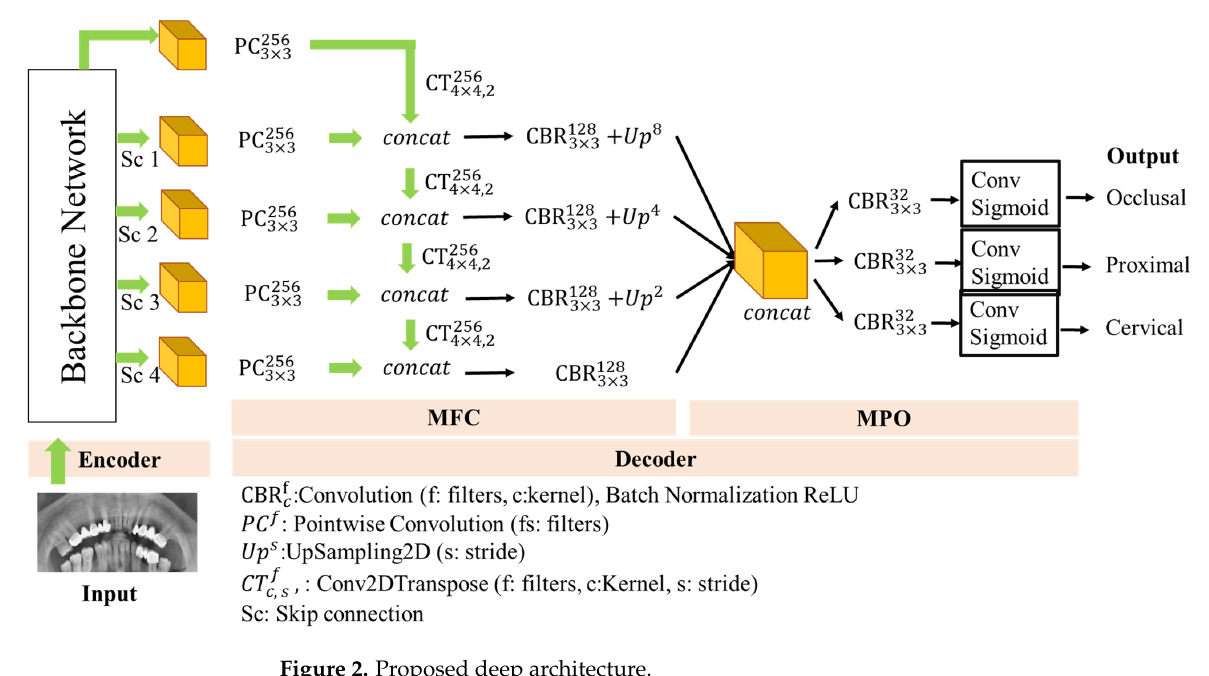
Figure 2. Proposed deep architecture.